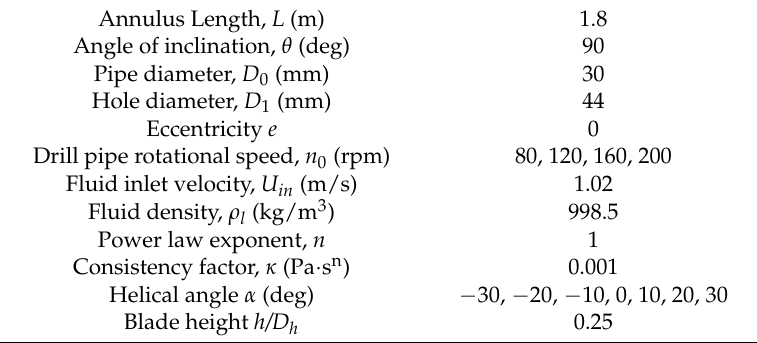
Table 1. Geometrical parameters and operating conditions in the numerical